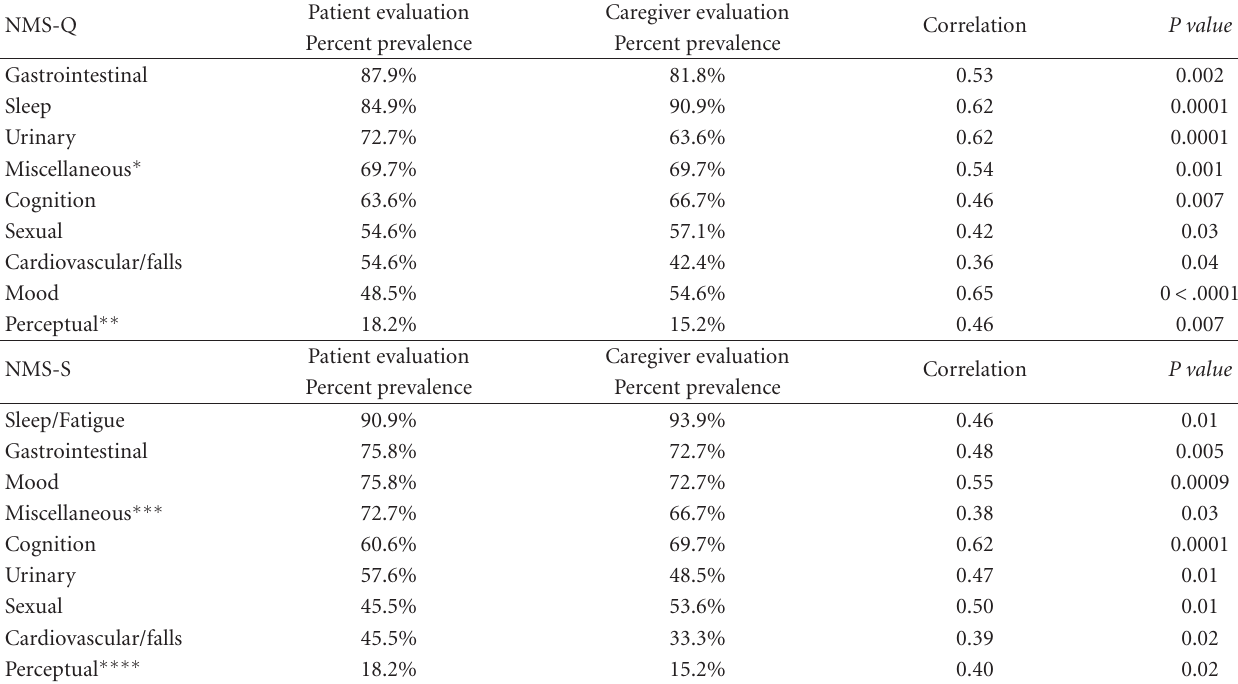
Table 1: Frequency of nonmotor symptoms. In the NMS-Q, at least 1 question in the category is “yes.” In the NMS-S, Severity “Frequency” is greater than 0 in at least 1 item in the